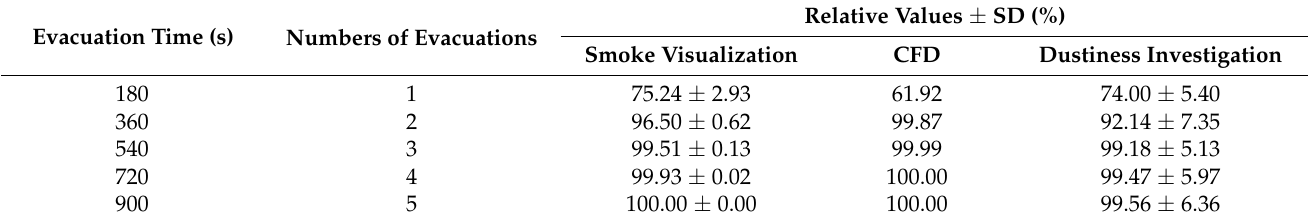
Table 4. Results of the three investigated methods for the determination of the evacuation time.